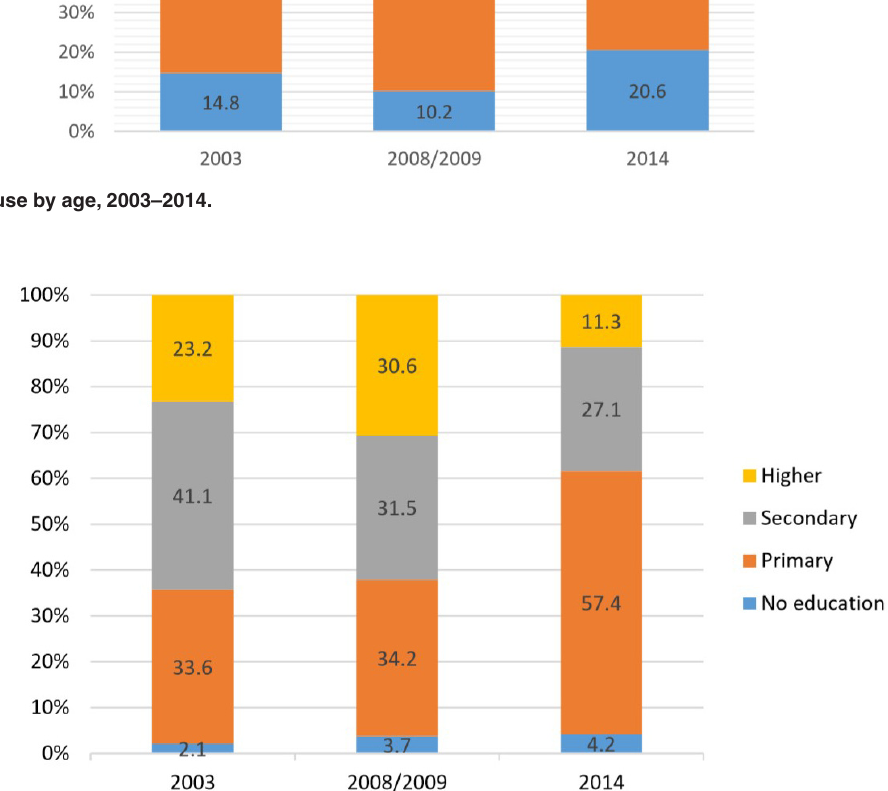
Figure 4. Implant use by education,